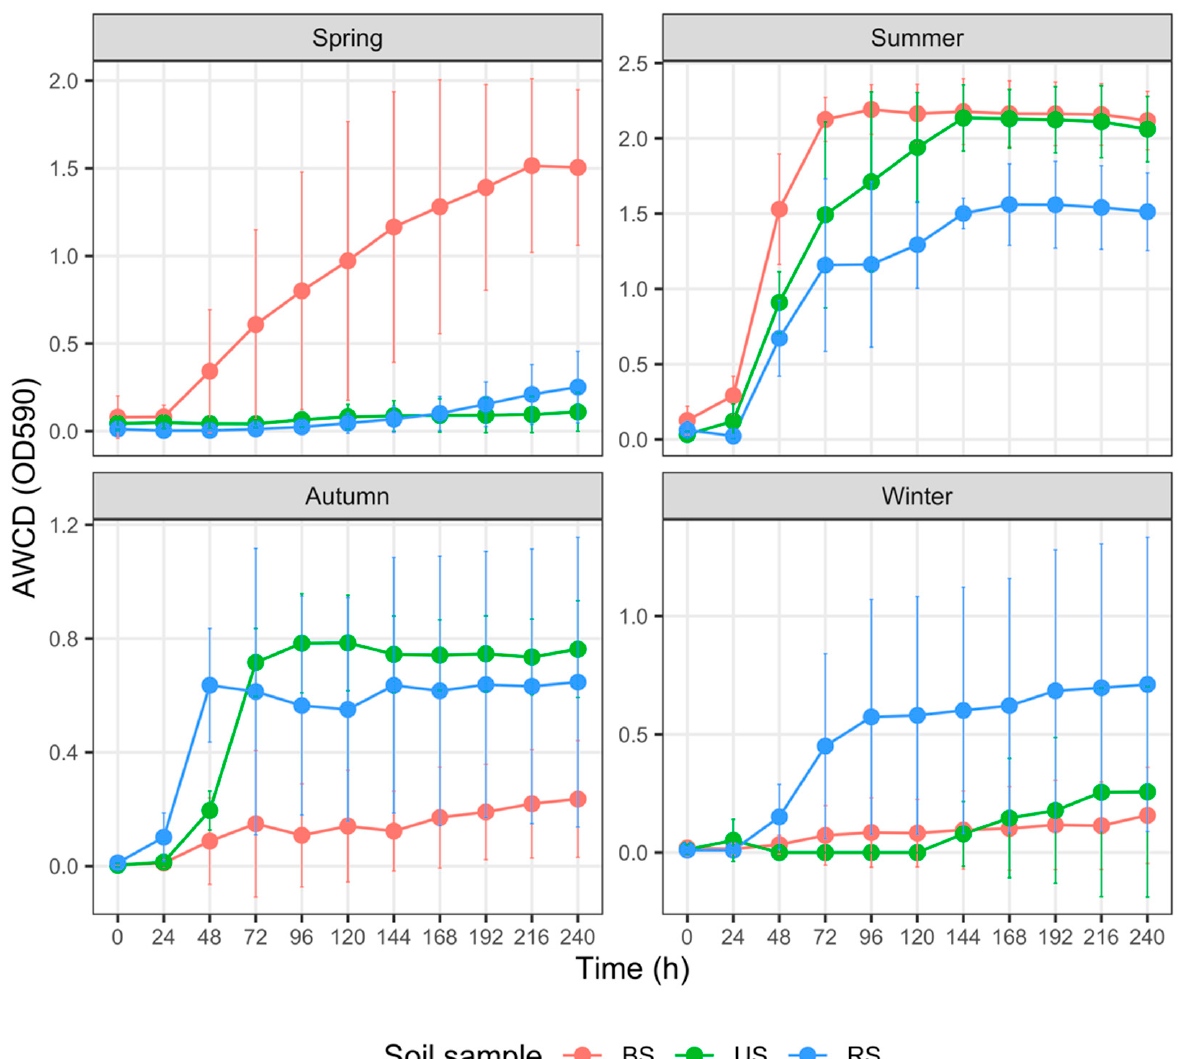
Figure 8. Variation in the average well color development (AWCD) of amines and amides among three groups of soil samples collected in different seasons. The error bar represents the mean ± SD ( n = 3). AWCD 240 for each soil sample was compared via the Kruskal–Wallis test. Abbreviations: